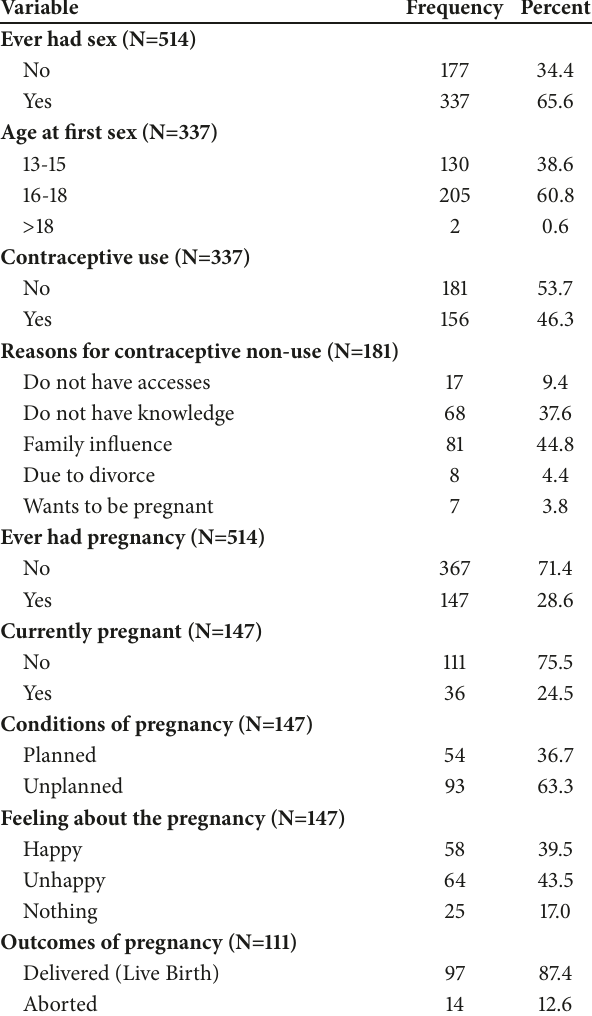
Table 2: Sexual and reproductive health characteristicsof teenagers in Wogedi, northeast Ethiopia,